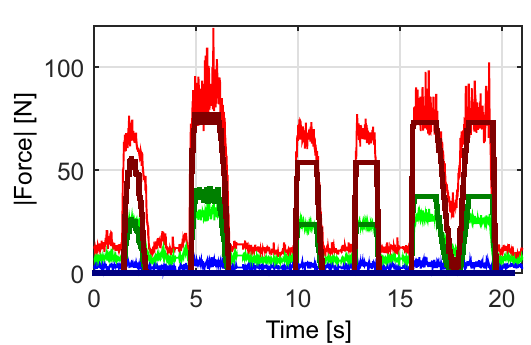
Figure 11. Comparison of the corrected measured and the simulated force signal in the case of down- and upmilling. Measured forces: (cid:4) - maximum, (cid:4) - aver- age, (cid:4) - minimum; Calculated forces: (cid:4) - maximum, (cid:4) - average, (cid:4) -